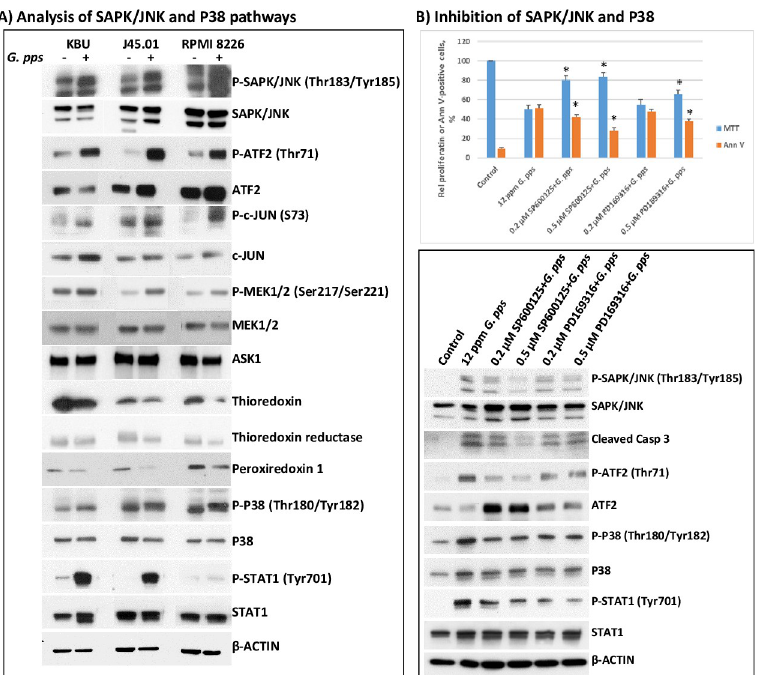
Fig 8. The stress-activated protein kinase/Jun-amino-terminal kinase (SAPK/JNK) is activated in cells exposed to extracts from Gymnopilus purpureosquamulosus ( G . pps ). (A) Leukemia (KBU), lymphoma (J45.01) and multiple myeloma (RPMI 8226) cell lines were exposed to DMSO (negative control) or 35 ppm G . pps extracts for 48 h and analyzed by Western blotting. (B) KBU cells were exposed to 12 ppm G . pps (IC 50 value) alone or with 1 h-pre- exposure to SAPK/JNK inhibitor SP600125 or P38 inhibitor PD169316 and analyzed for proliferation (MTT), apoptosis (Ann V) and changes in the level of modifications of proteins involved in the SAPK/JNK and P38 signaling pathways. The MTT and Ann V results are average of three independent experiments and asterisk indicates statistically significant difference ( P < 0.05) when compared with 12 ppm G . pps alone.